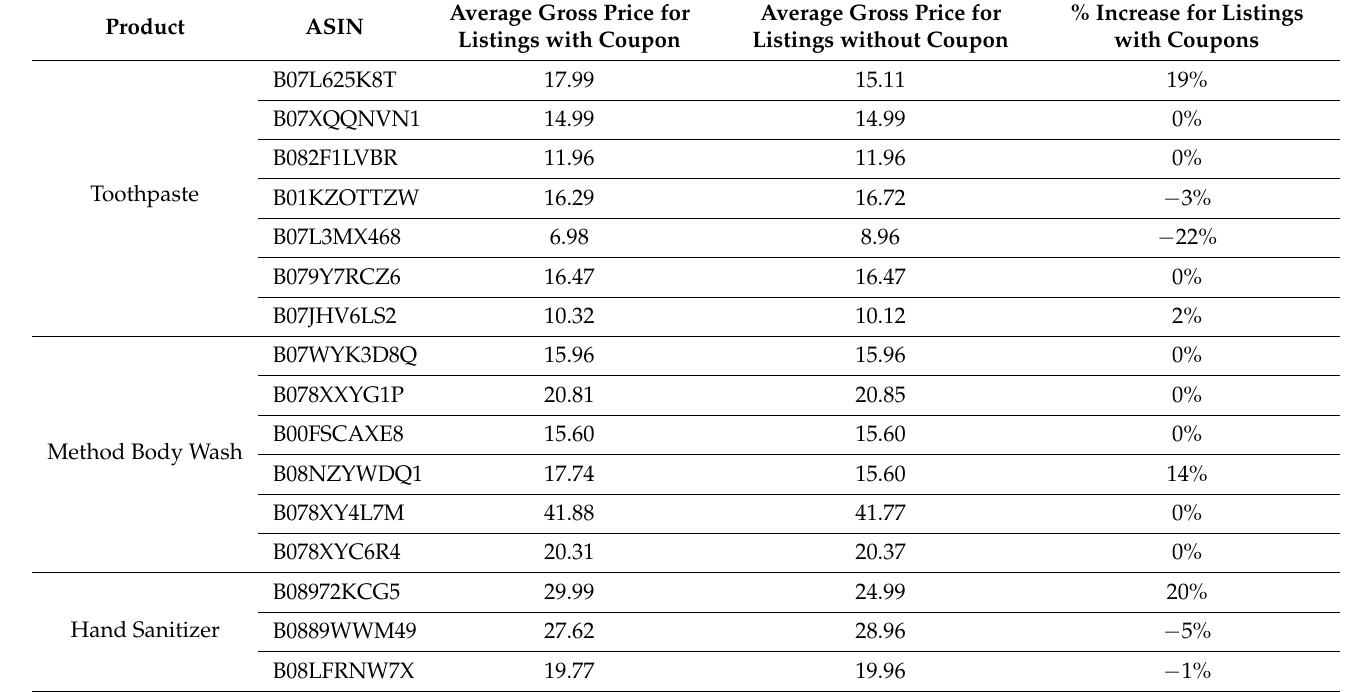
Table 4. Comparison between gross price for listings with and without